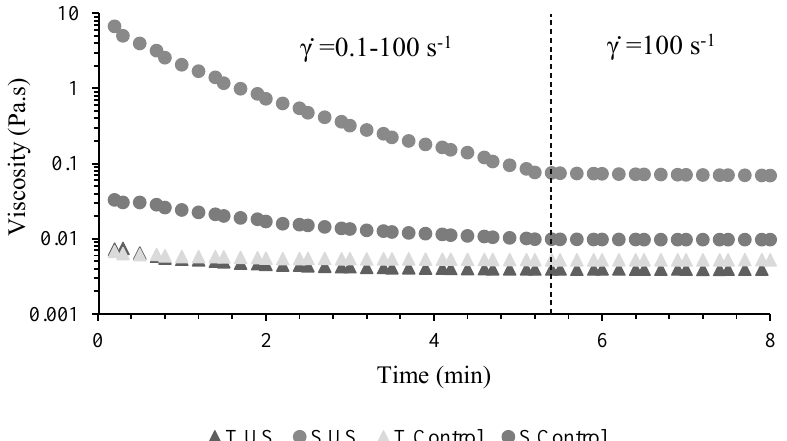
Figure 1. Rheological behavior during rotational flow test of obtained whey protein-thyme EO nanoemulsions. T US-ultrasonicated T nanoemulsion, S US-ultrasonicated S nanoemulsion, T Control, S Control.